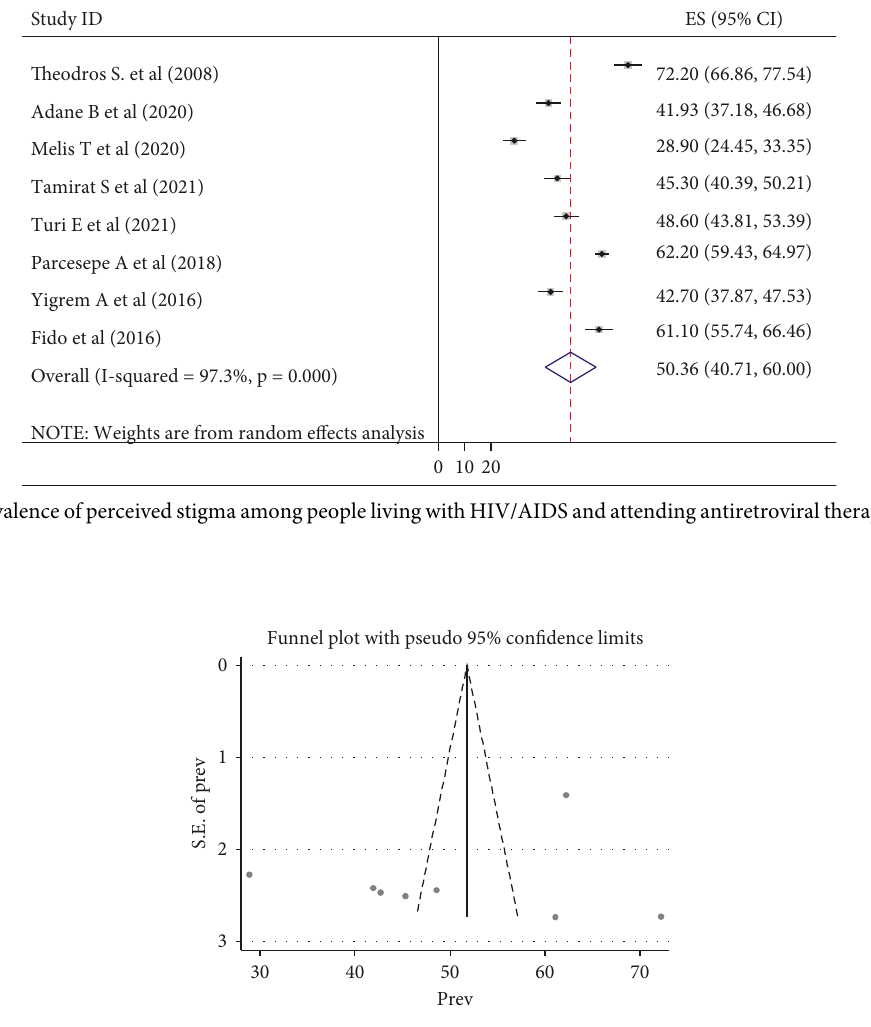
Figure 3: Funnel plot graph on the pooled prevalence of perceived stigma among people living with HIV/AIDS and attending antiretroviral therapy in Ethiopia, 2021.